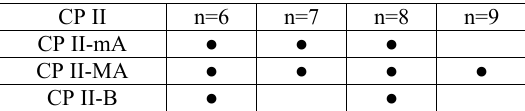
Table 1: All possible shapes of Concave pyramids of the second